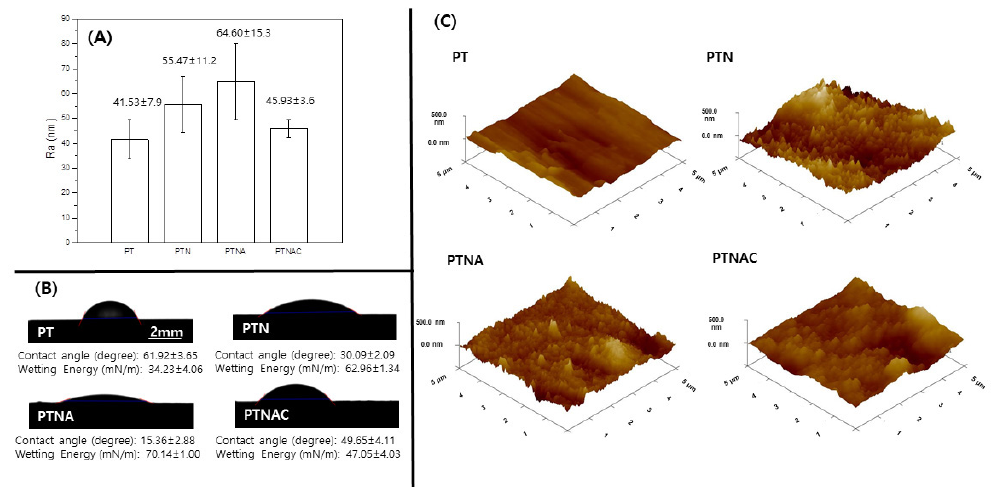
Figure 3. ( A ) Surface roughness value; ( B ) contact angle; ( C ) and atomic force microscopy (AFM) image of PT and surface-treated (PTN, PTNA, and PTNAC) specimens.